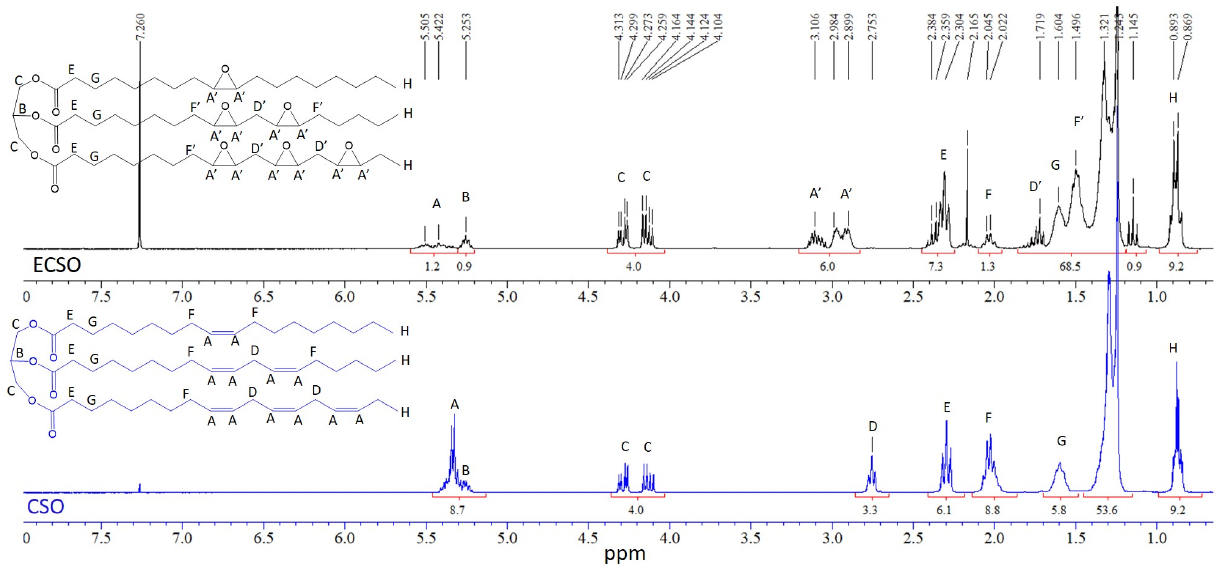
Figure 1. NMR spectra of CSO (cottonseed oil) and ECSO (epoxidized cottonseed oil). The NMR spectra of intermediate samples taken during the reaction are shown in Figure 2. With the epoxidation programming, the peak intensity of the CH=CH double bond was clearly decreased, while the signal of the oxirane ring conversely appeared at 3.00 ppm.